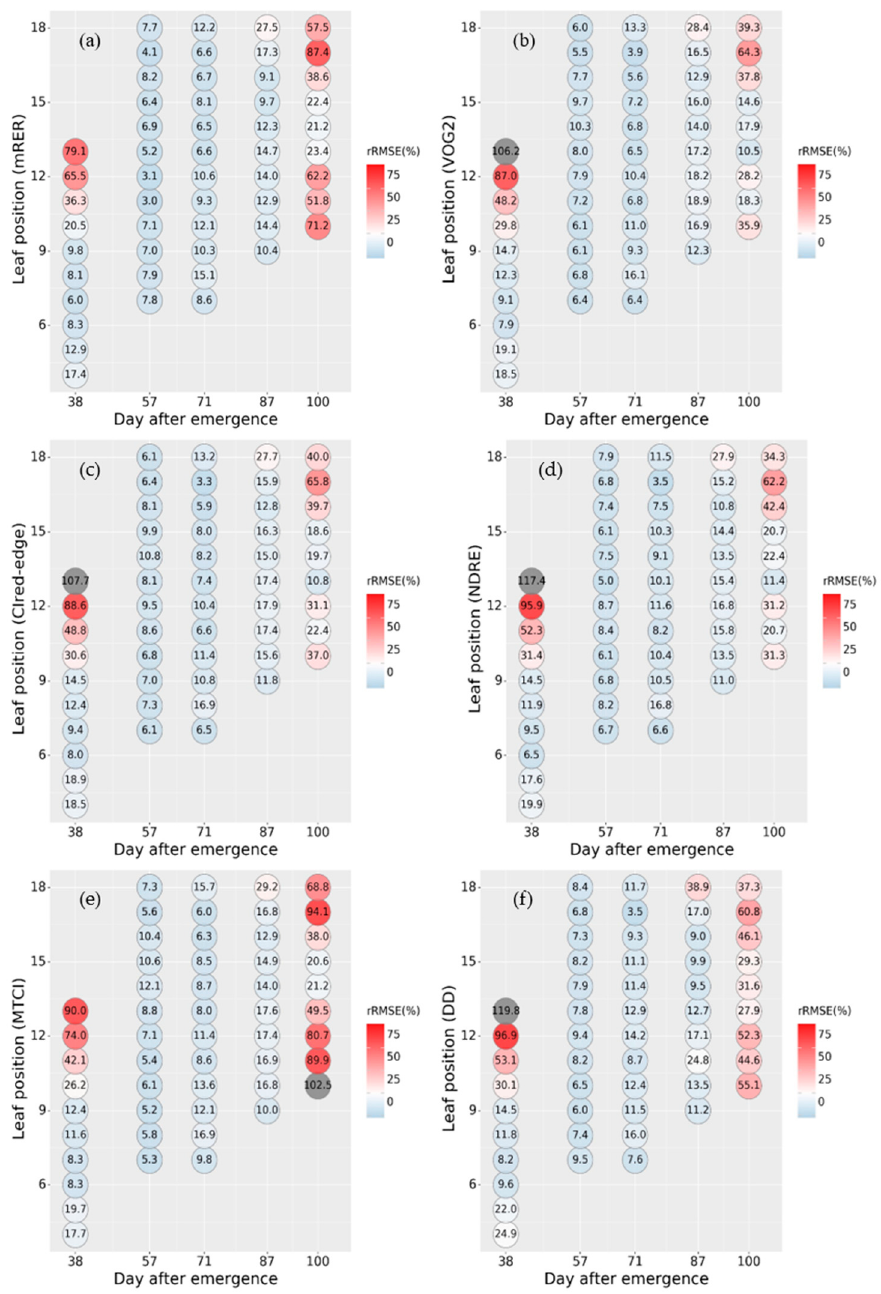
Figure 5. rRMSE (%) for the six LCC-VI models: ( a ) mRER, ( b ) VOG2, ( c ) CIred-edge, ( d ) NDRE, ( e ) MTCI, and ( f ) DD. rRMSE was used to evaluate the model inversion accuracy. Lower values of rRMSE correspond to closer predicted and observed values. The x-axis represents days after first leaf emergence, and the y-axis represents the canopy position where the leaves were located (L1–L18 from the bottom to the top of the plant). Blue indicates a low rRMSE value (low error), and red indicates a high rRMSE value between the observed and predicted LCC. Gray indicates error of more than